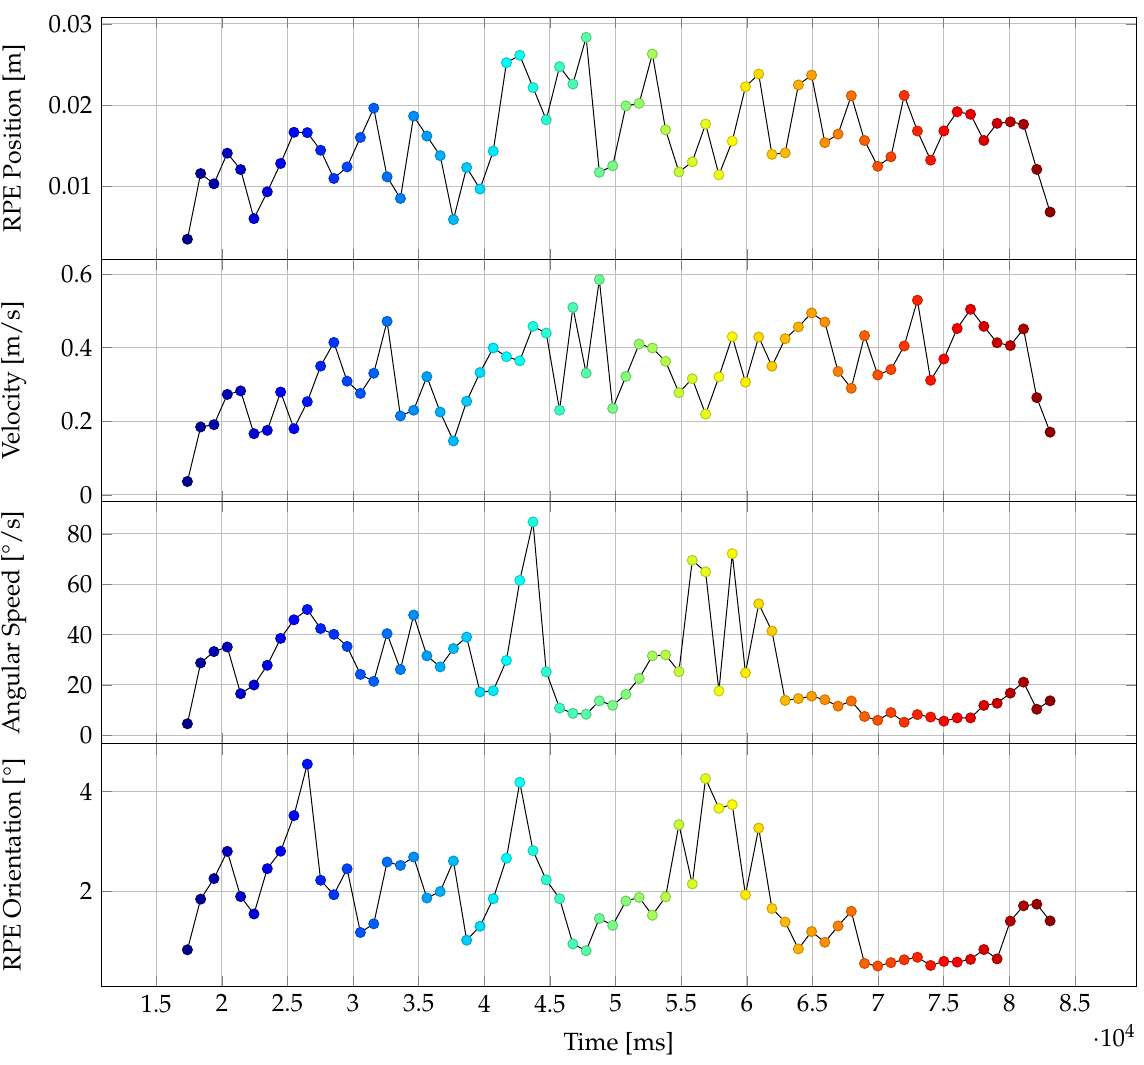
Figure 14. Velocity and RPE values over the course of the trajectory depicted in Figure 13. The color range is the same as the one from Figure 13, symbolizing the time going from blue to